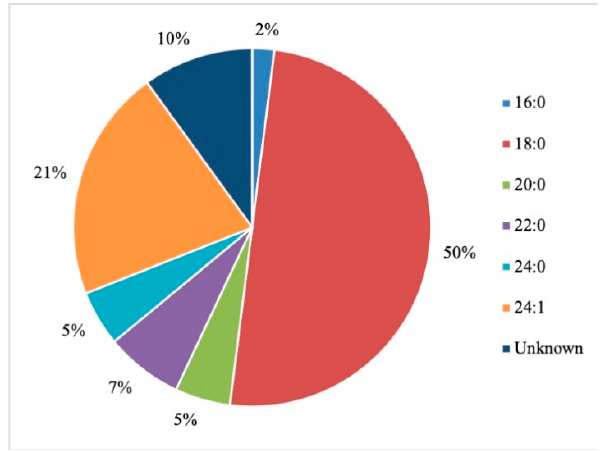
Figure 8. Average fatty acid distribution of porcine brain SM. Adapted from Avanti polar lipids; https://avantilipids.com/product/860062.